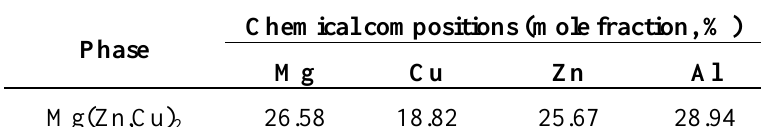
Table 2. Results of TEM-energy dispersive spectroscope (EDS) analysis of the precipitates shown in Figure